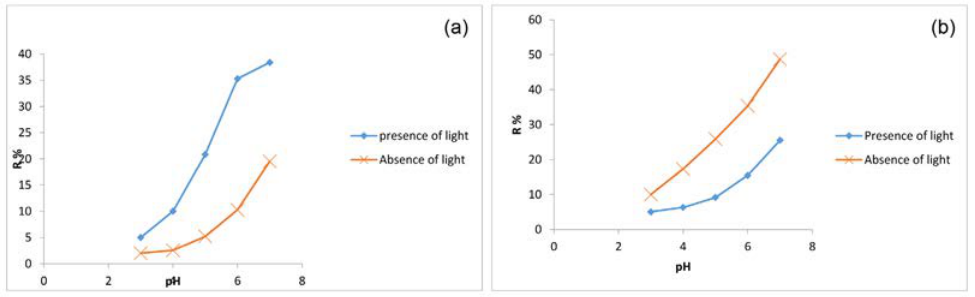
Fig. 4. Effect of pH on the removal of lead ion in the presence and absence of light by Nanocomposites (a) Nd-TiO bentonite (b) Ce-TiO